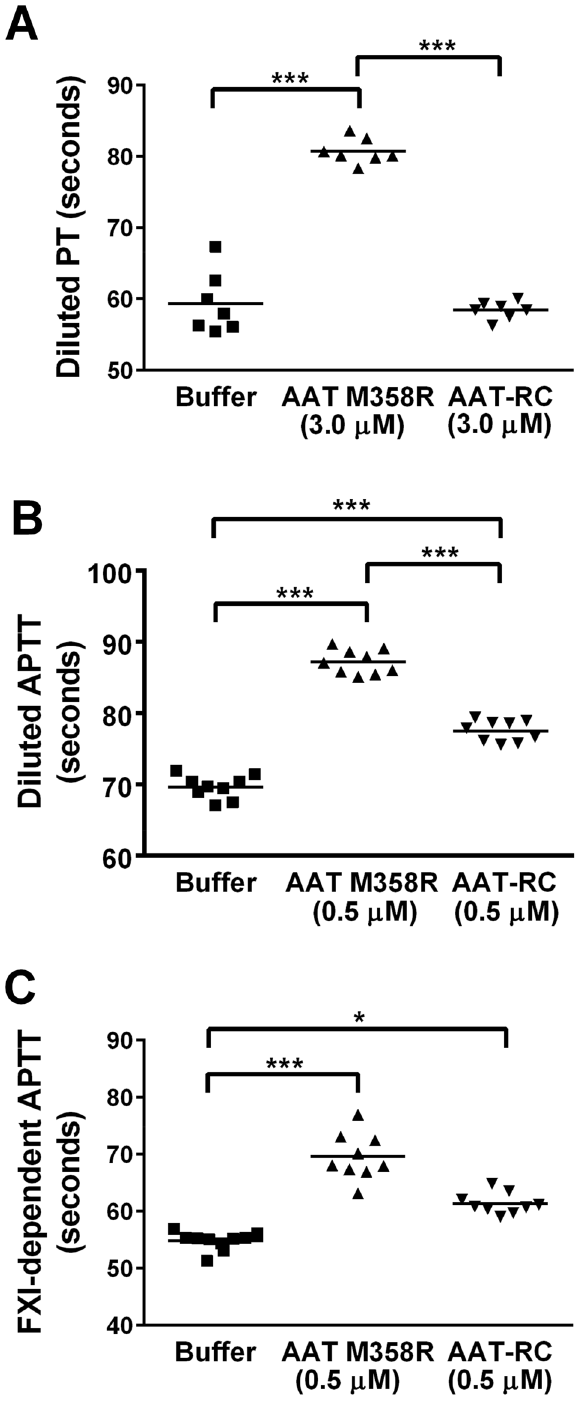
Figure 5. Effects of AAT M358R or AAT-RC on modified hemostasis screening tests. Buffer or purified AAT M358R was introduced at either 0.5 µM or 3.0 µM final concentrations (as labelled on x axes) into diluted PT (Panel A ), diluted APTT (Panel B ), or FXI-dependent APTT assays. Note y axis does not commence at 0 s. Each point is a single determination. Horizontal capped lines linking groups indicate statistical differences by ANOVA with post-tests: * p < 0.05; ** p < 0.01; and *** p <